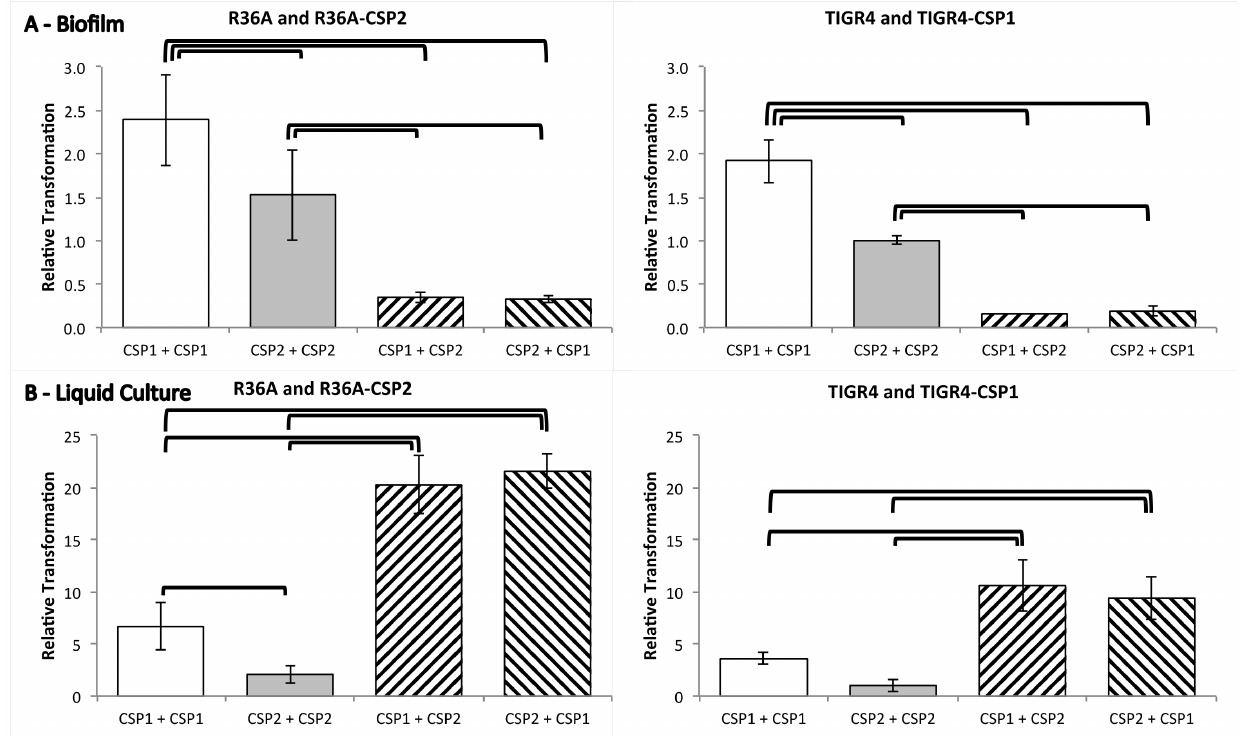
Figure 6. Comparison of intra-pherotype and inter-pherotype recombination in biofilms and liquid cultures. Each bar represents the fraction of double resistant CFUs in the total number of CFUs, normalized by the same fraction obtained for TIGR4 intrapherotype transformation (0.048 in biofilm and 4.1 6 10 2 6 in liquid culture). Experiments were performed both in biofilm (panel A) and in liquid culture (panel B) by mixing equal amounts of two strains, each with one antibiotic resistance marker (novobiocin and streptomycin). In each experiment, the two leftmost bars represent mixtures of strains with the same pherotype and on the right pherotypes were mixed to evaluate inter-pherotype recombination. White bars represent mixtures of CSP1 producing strains, grey bars CSP2 producing strains and hatched bars mixtures of CSP1 and CSP2 producing strains. In the left slanted hatched bars the CSP1 producing strain carried the novobiocin resistance marker, while the CSP2 producing strain carried the streptomycin resistance marker. In the right slanted hatched bars the resistance markers on the strains were reversed. Results show that in biofilms intra-pherotype recombination is more frequent than inter-pherotype recombination. The opposite relationship is observed in liquid culture. Error bars represent the 95% confidence intervals of the mean of 3 or 9 (biofilms and liquid culture, respectively) independent experiments. Each independent biofilm experiment consisted of 3 technical replicates. ANOVA was applied to identify significant differences in the fraction of transformants between the four types of mixed cultures. Significant differences were found (p , 10 2 4 ) for both R36A and TIGR4 backgrounds and in both biofilm and liquid culture. Groups with significant differences according to post-hoc analysis are identified in the figure by horizontal brackets. In all cases p , 10 2 3 , except for the difference in transformants obtained in liquid culture with the R36A background between CSP1 + CSP1 and CSP2 + CSP2 mixtures, where p , 10 2 2 .